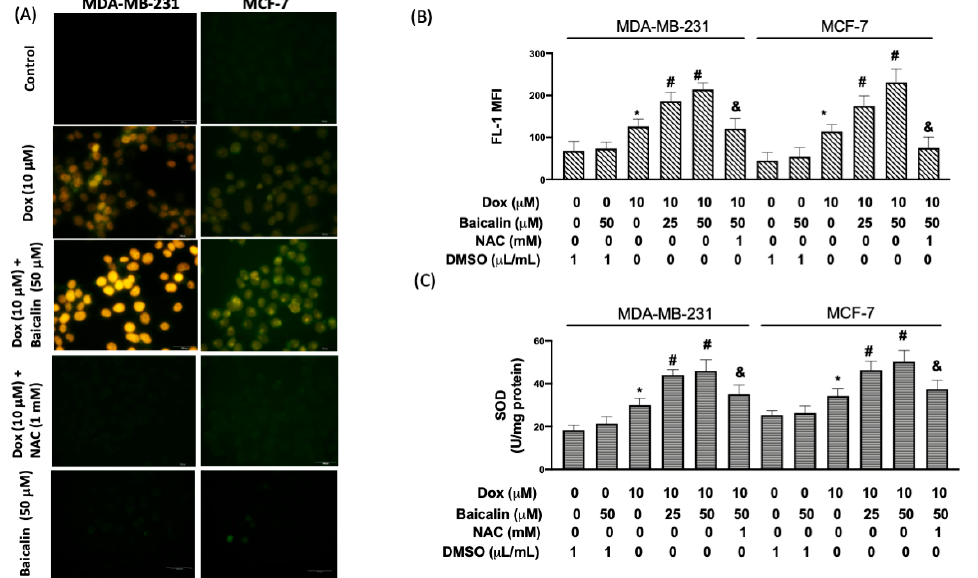
Figure 2. Baicalin enhances Dox-induced oxidative stress in MDA-MB-231 and MCF-7 breast cancer cells. Cells were treated with 10 μ M Dox or 10 μ M Dox plus 50 or 25 μ M baicalin for 24 h. DCF – DA was used to study ROS levels. Images are shown under a fluorescence microscope ( A ). ROS levels (mean fluorescence intensity; MFI) were investigated by flow cytometry ( B ). SOD activity was mitigated in cells treated with Dox and baicalin; in some cells, NAC pretreatment inhibited oxidative stress ( C ). Data are expressed as the mean ± SEM of three independent analyses; * p < 0.05 versus untreated control, # p < 0.05 versus Dox treatment, & p < 0.05 versus Dox+Baicalin (50 μ M) treatment.